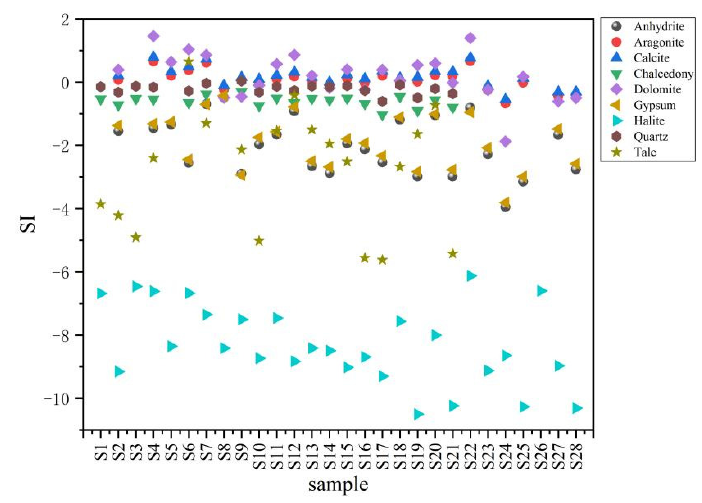
Figure 7. Saturation indices values of groundwater samples with respect to minerals.